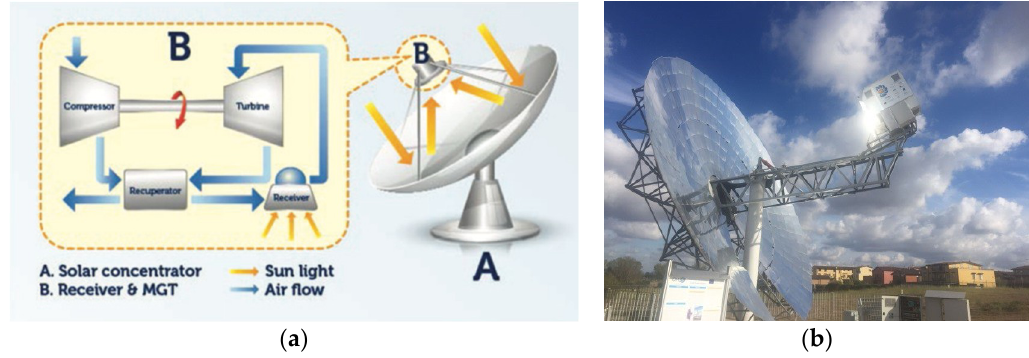
Figure 12. Parabolic dish, ( a ) Conceptual scheme (A-dish solar concentrator, B–receiver and micro gas turbine) and ( b ) parabolic dish at ENEA [14].